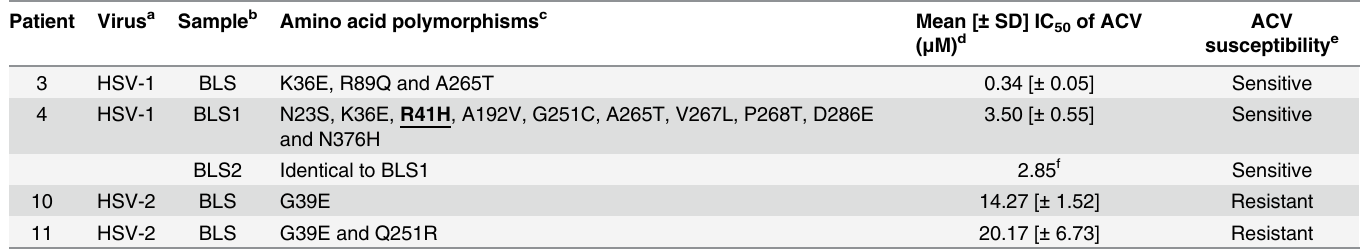
b Sample type. BLS: blister swab.